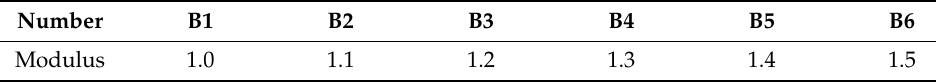
Table 5. Modulus of specimen group B.